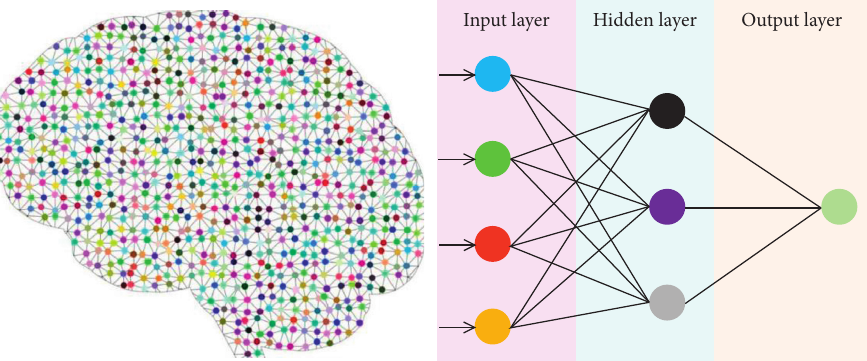
Figure 1: BP neural